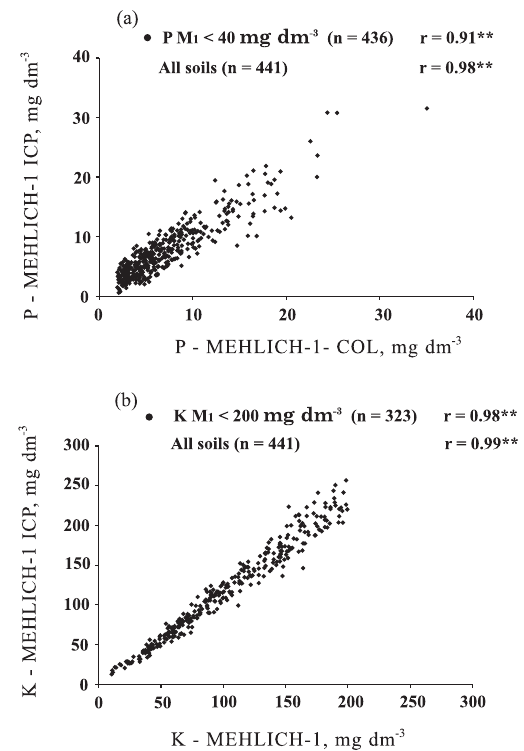
Figure 1. Correlation between the phosphorus amounts extracted by the Mehlich-1 solution determined by the colorimetric (COL) and ICP methods (a) and the K amounts extracted by the Mehlich-1 solution determined by the flame emission (EM) and ICP